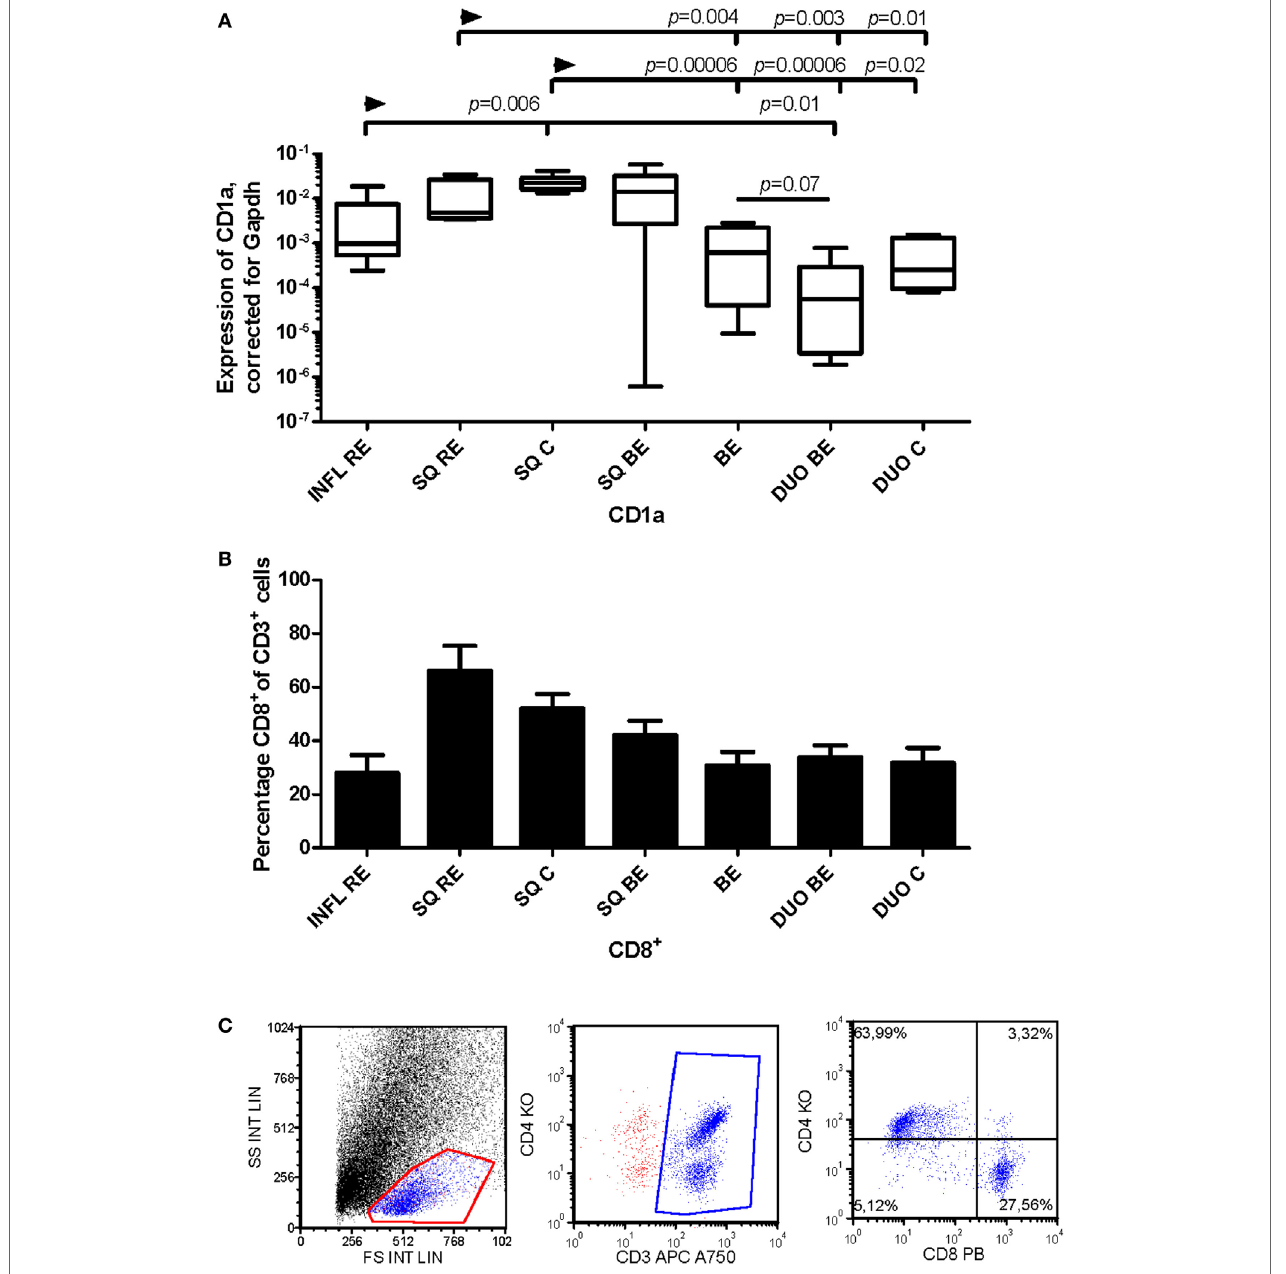
FigUre 6 | Lower expression of CD1a in Barrett’s esophagus (BE) is associated with lower numbers of CD3 + CD8 + -cells in tissue. Panel (a) depicts expression of CD1a by RT-PCR performed on a total of: reflux esophagitis (RE) biopsies from inflamed squamous tissue (INFL RE, n = 9), non-inflamed squamous esophageal epithelium from RE patients (SQ RE, n = 9), squamous esophageal epithelium from controls (SQ C, n = 12), squamous esophageal epithelium from BE patients (SQ BE, n = 10), BE biopsies (BE, n = 11), duodenal biopsies from BE patients (DUO BE, n = 10), and duodenal biopsies from controls (DUO C, n = 5). CD1a expression was corrected for GAPDH, 2 −Δ CT ± SEM. Panel (B) represents the percentage of CD3 + CD8 + -cells from ex vivo cultures of 7 biopsies from inflamed RE tissue (INFL RE), 6 non-inflamed squamous esophageal biopsies from RE patients (SQ RE), 39 controls (SQ C), 17 squamous esophageal biopsies from BE patients (SQ BE), 19 BE biopsies (BE), 15 duodenal biopsies from BE patients (DUO BE), and 11 duodenal biopsies from controls (DUO C). Each bar represents the mean value ± SEM of the percentage of CD3 + CD8 + -cells in the CD3 + population, determined by flow cytometry. Data were analyzed using the Kruskal–Wallis test (CD1a: p < 0.0001, CD3 + CD8 + : p = 0.0002). p -values from comparing individual groups were obtained by using Mann–Whitney U test in case of individual groups, and Wilcoxon signed rank test for different tissue types from the same patient. Adjustment for multiple comparison was conducted by Benjamini–Yekutieli method. (c) Dot plot of a CD3 + , CD4 + , and CD8 + staining on lymphocytes from ex vivo culture of duodenal tissue from BE patient. Cells were gated first on a forward sideward scatter plot and for CD3.